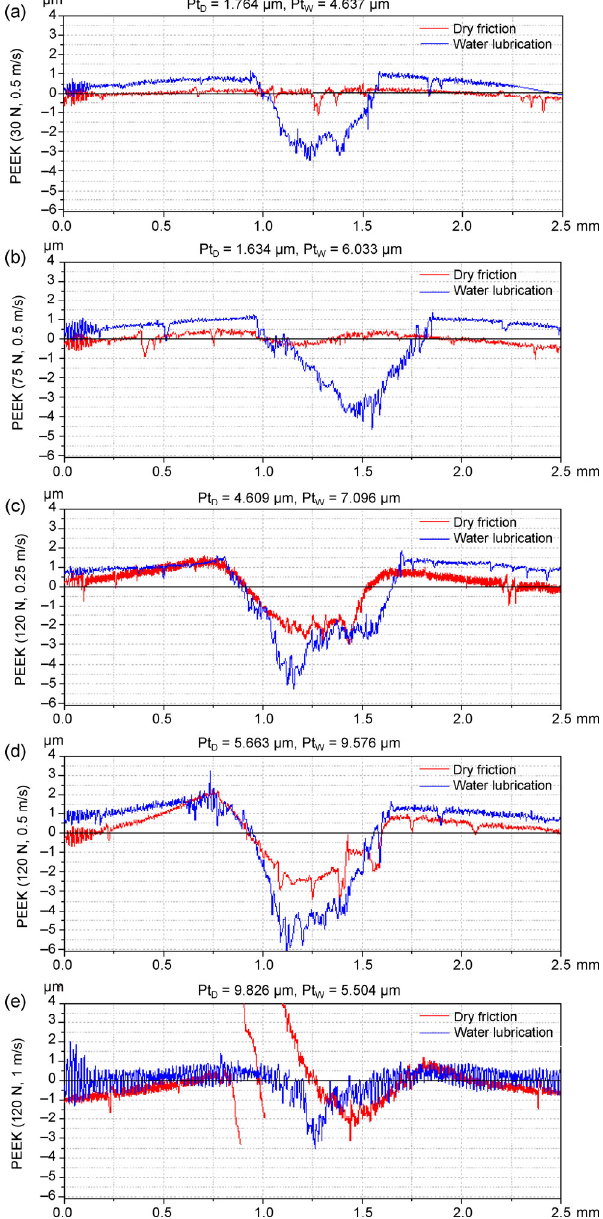
Fig. 10 Cross-sectional profiles of wear tracks from 2-D PEEK surface